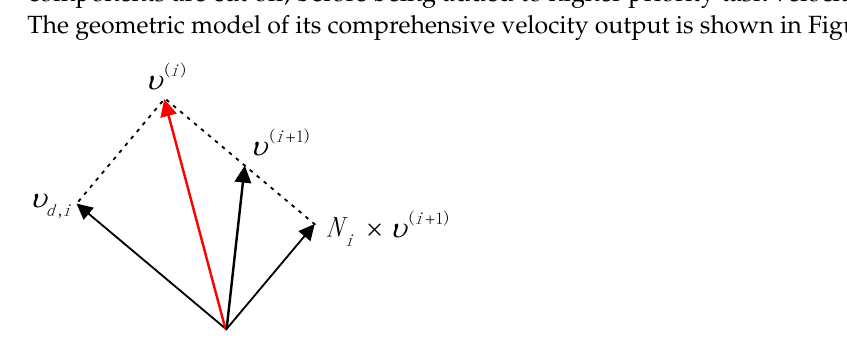
Figure 1. Task velocity composition in the NSBC framework. The velocity v ( i + 1 ) is projected into the null space of the higher priority task and added to v d , i . Finally, v d , i and N i × v ( i + 1 ) get the composite task speed v i through the vector